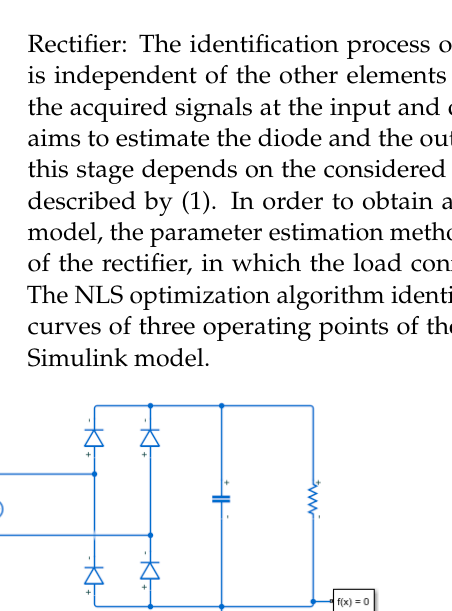
Figure 6. Simulink model of the EMI filter.